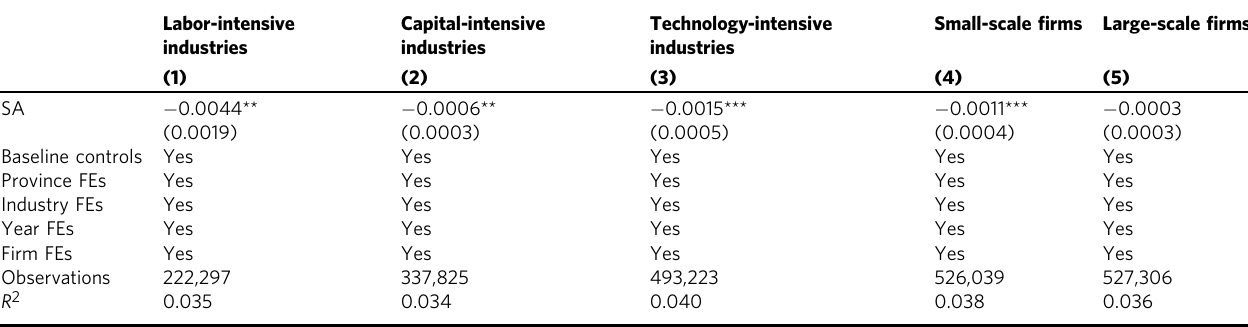
Table 10 Heterogeneity